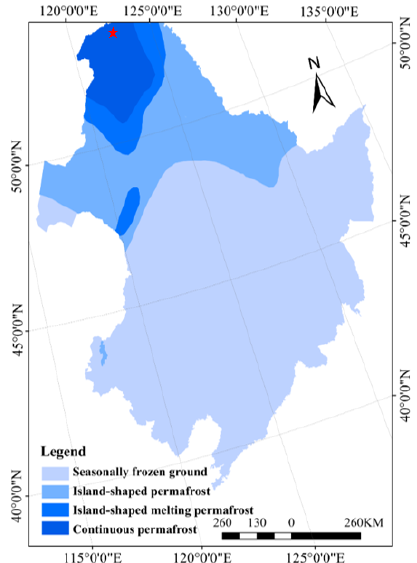
Figure 1. Location of the study sites. Red asterisk represents the sampling site.